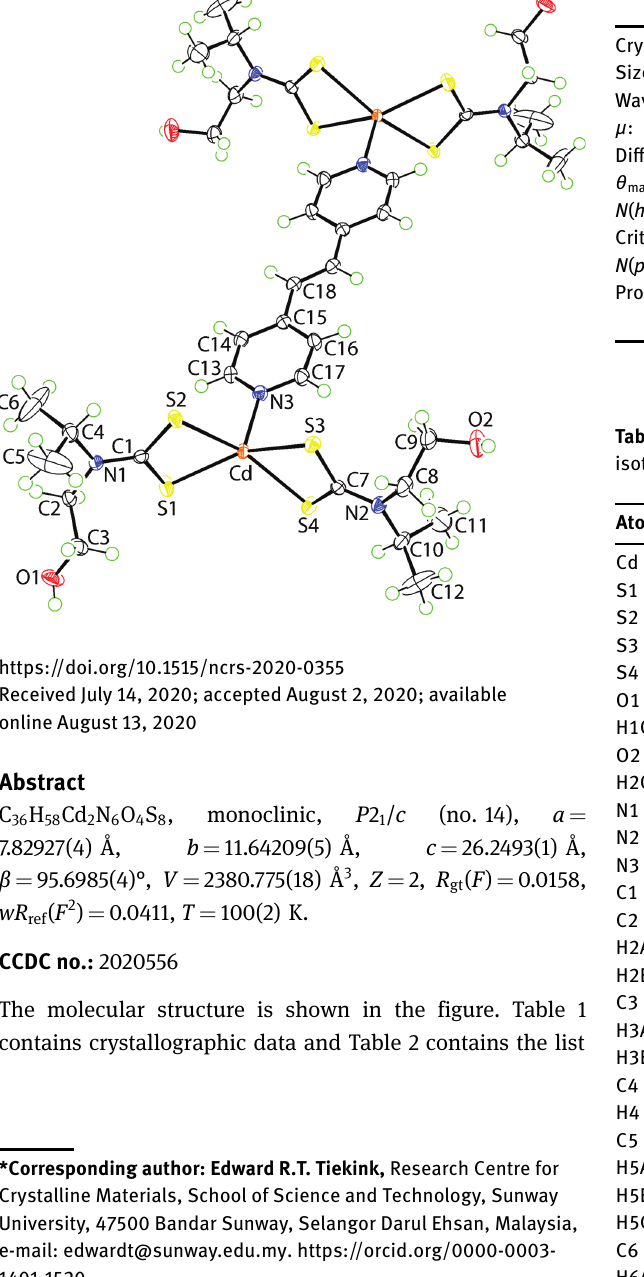
Table 1: Data collection and handling.